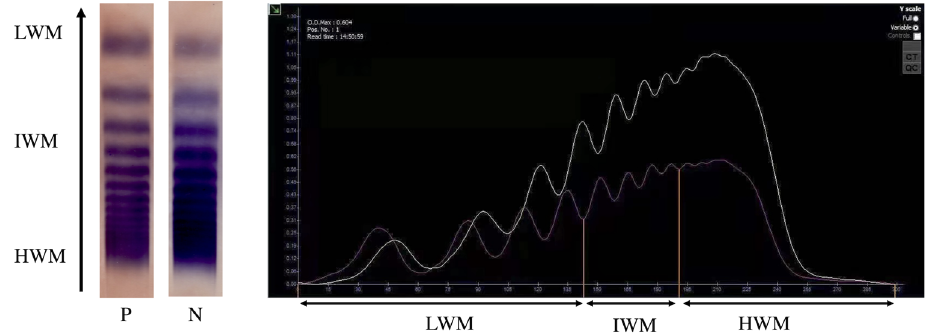
Figure 1. Multimer analysis of von Willebrand factor using agarose gel electrophoresis and densitometry patterns from the test system (Sebia, France) showing the loss of high and intermediate molecular weight von Willebrand factor. (P = this patient, N = control, LMW = low molecular weight, IMW = intermediate molecular weight, HMW = high molecular weight).